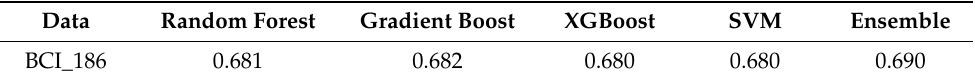
Table 2. The accuracy of the ensemble model that used several models together was the highest.